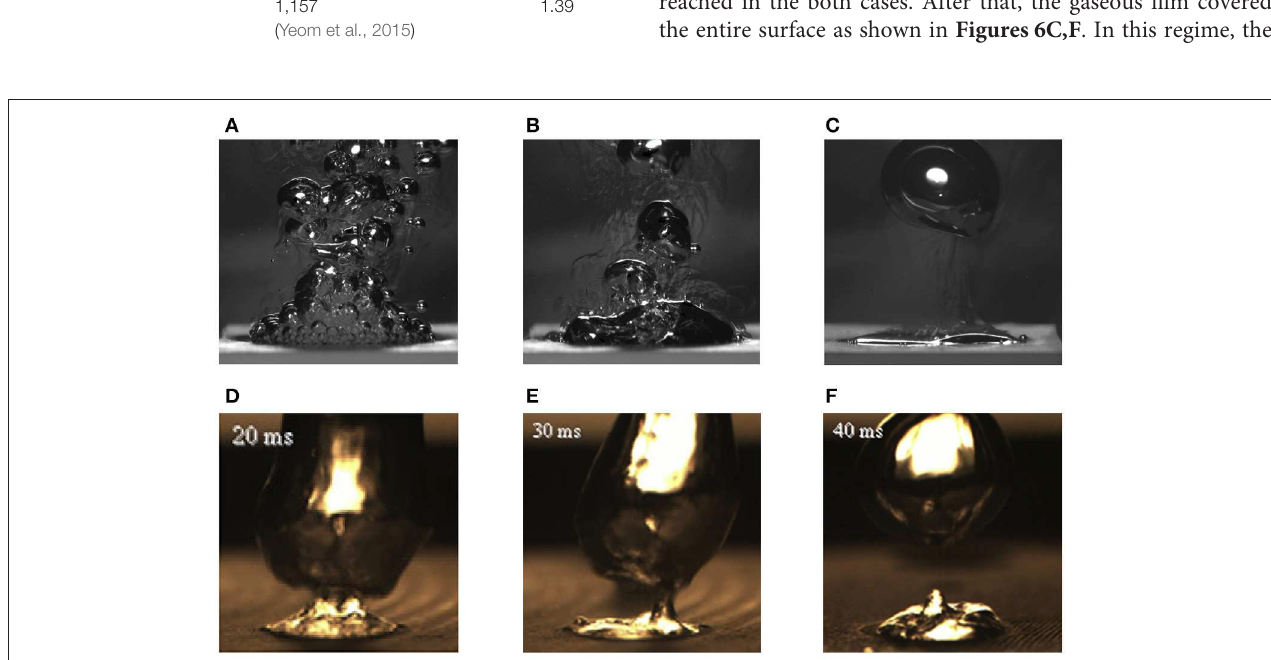
FIGURE 6 | Comparison of bubble behaviors between hydrogen evolving and water boiling system. (A) Just before CCD, (B) at CCD triggers, (C) after CCD, (D) just before CHF, (E) at CHF triggers, and (F) after CHF.